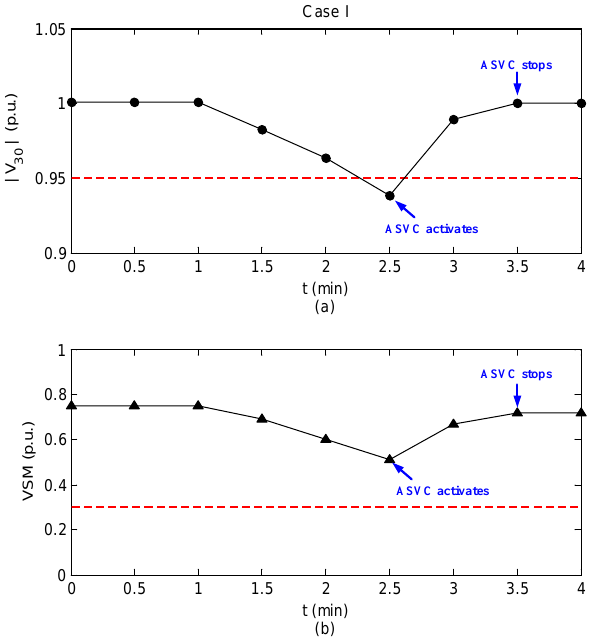
V ; ( b ) The trace of VSM. Figure 6. Simulation result of case I. ( a ) The trace of | V 30 | ; ( b ) The trace of 30